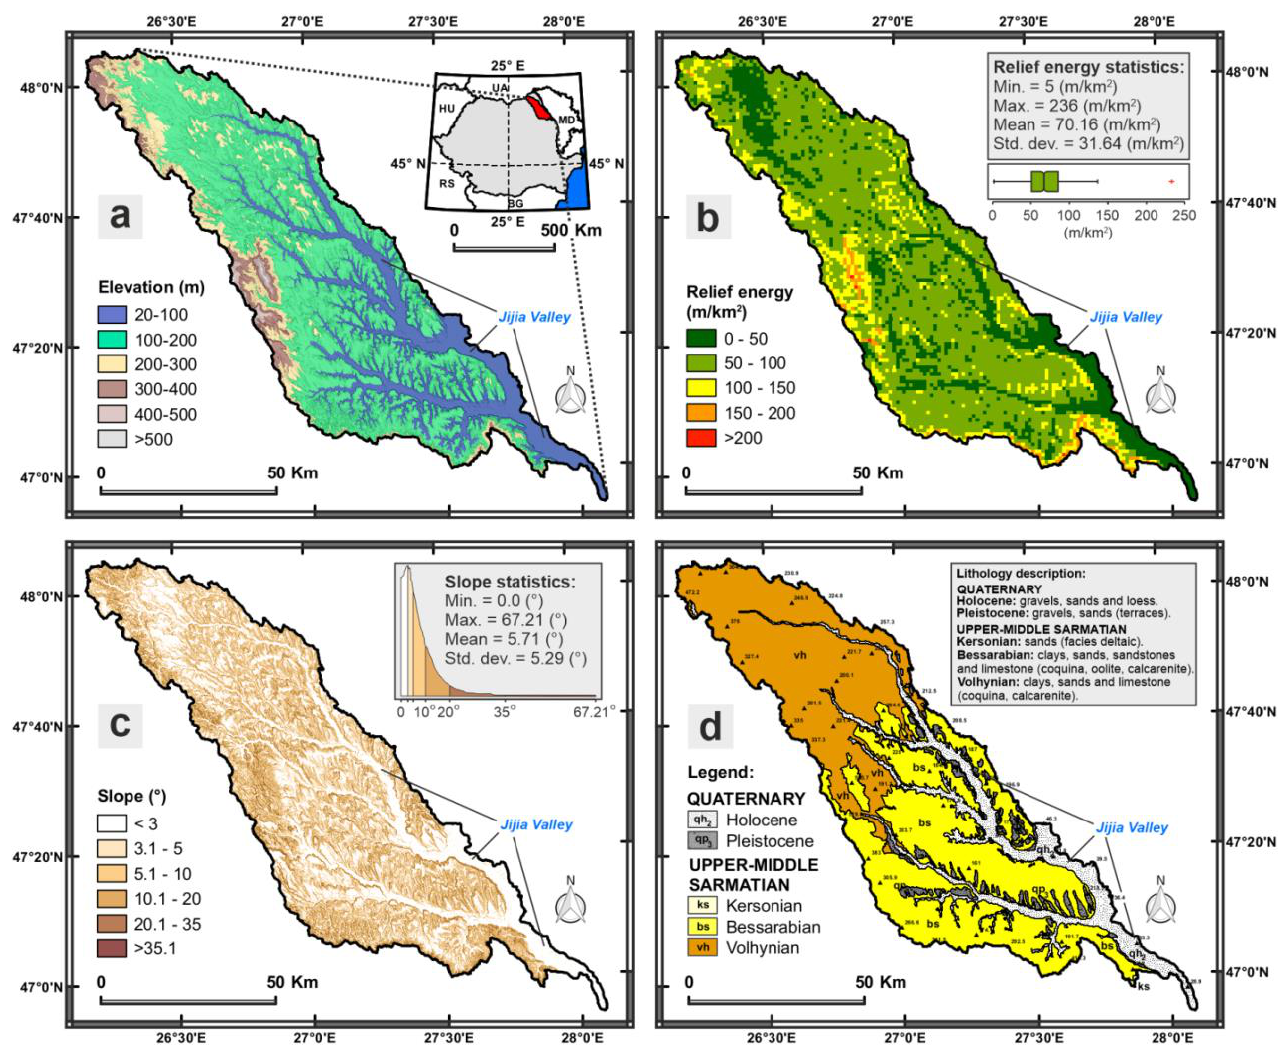
Figure 1. Geographic location of Jijia river basin in northeastern Romania with ( a ) elevation, ( b ) relief energy, ( c ) slope and ( d ) geological sketch maps.